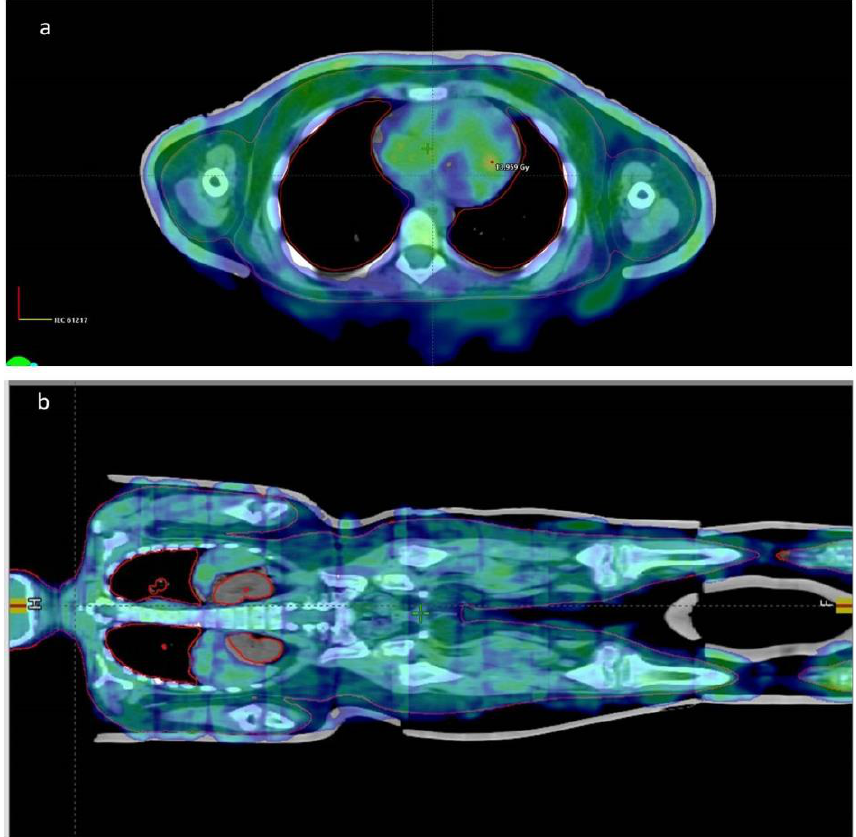
Figure 5. Isoshield dose coverage at 90% dose description on coronal ( a ) and transverse planes ( b ). No acute complications related to TBI were observed during the treatment period.